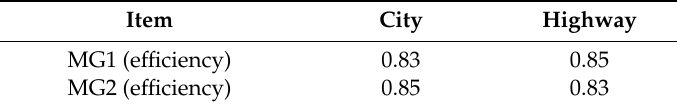
Table 6. Motor / generator e ffi ciency in